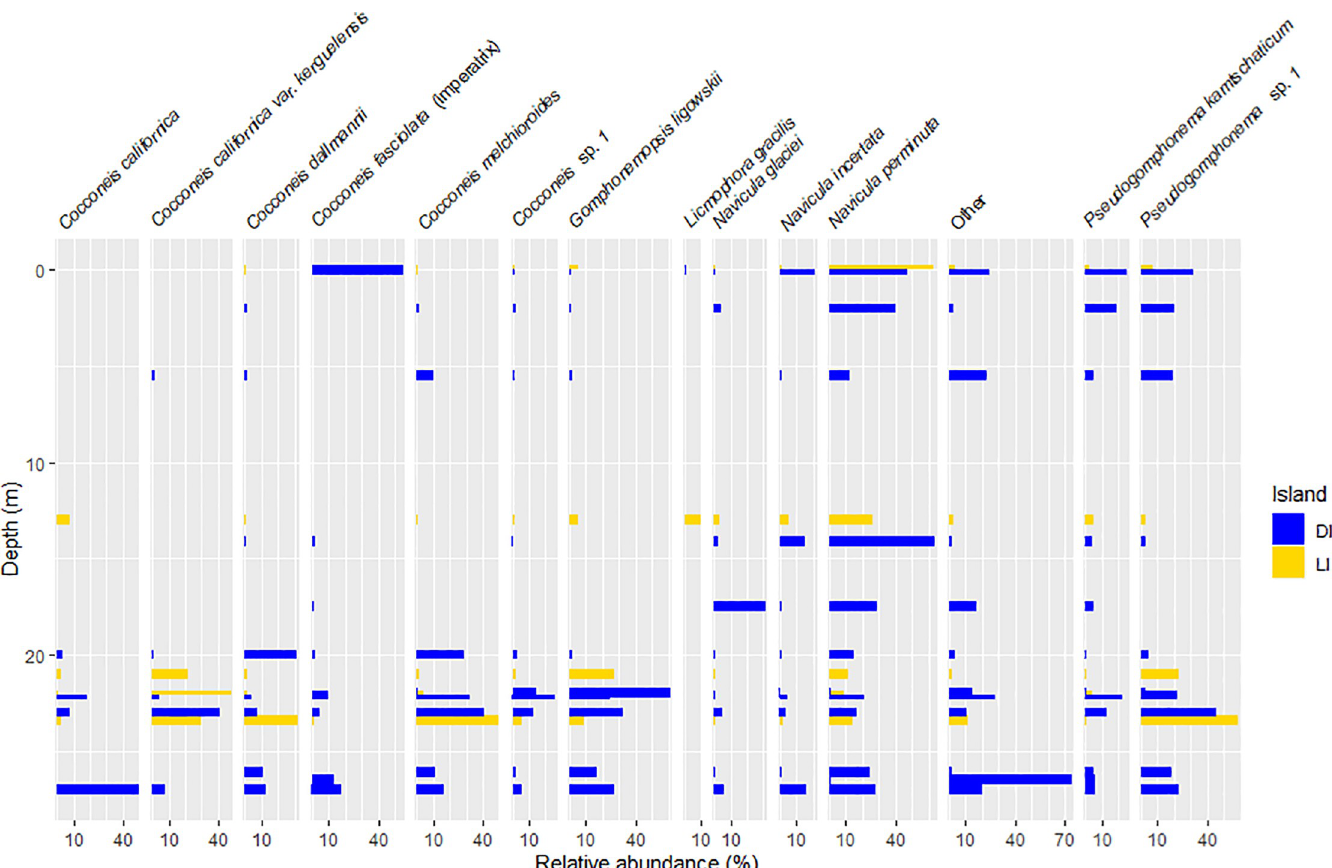
Fig 6. Depth diagram of diatom distribution in Deception and Livingston Island. The rest of diatoms found are summarized in the “Other” panel.